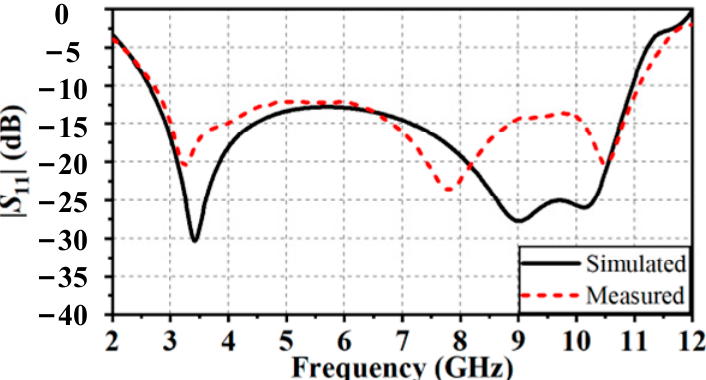
Figure 9. Simulated and measured | S 11 | of the proposed 3D absorber under the normal incidence.